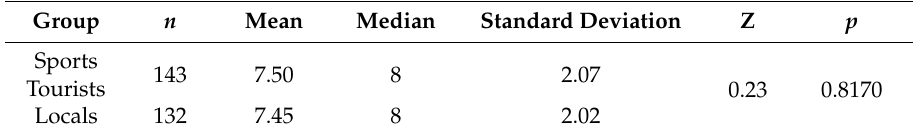
Table 11. The level of intensity of the motivation to participate in the Poznan Half Marathon in the future—depending on the place of the residence.